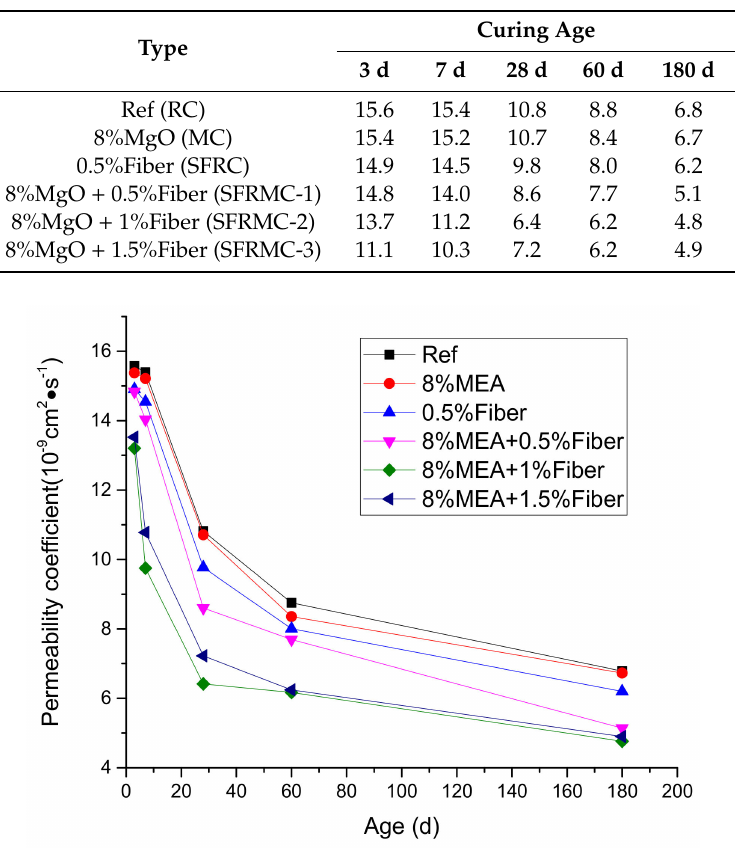
Table 3. Chloride di ff usion coe ffi cient of concrete specimens (10 − 9 cm 2 / s).